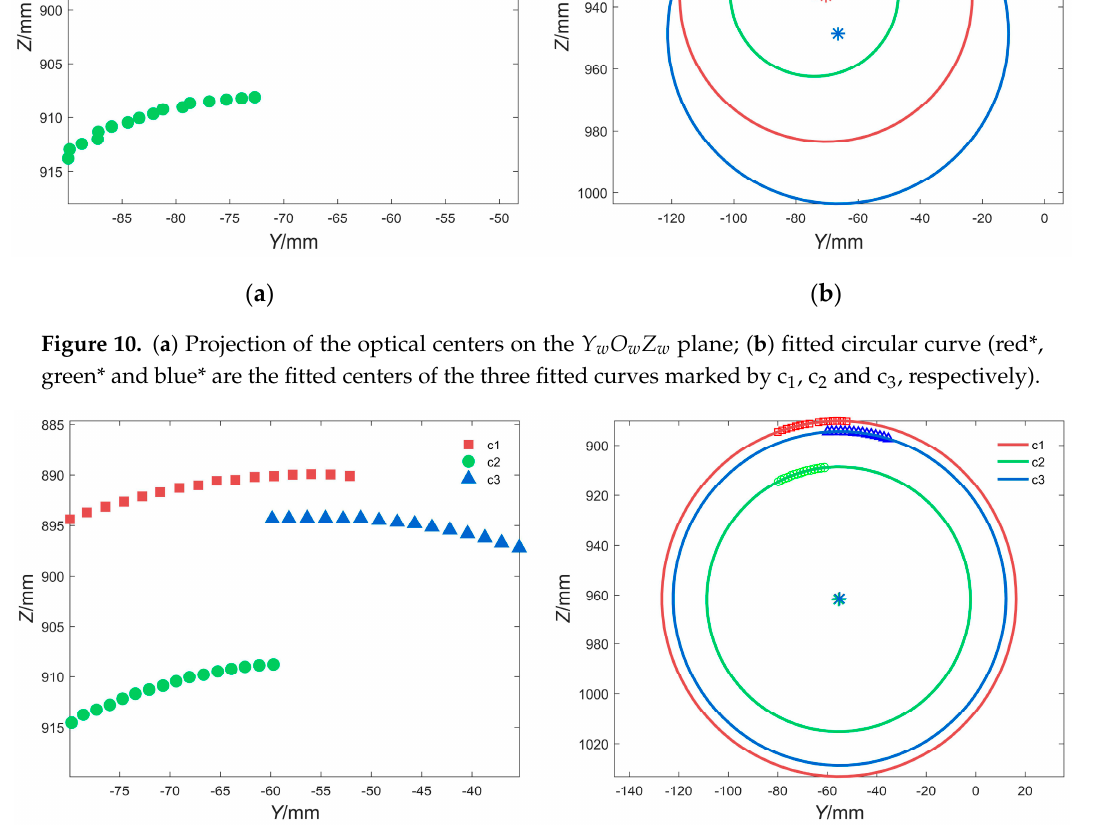
Figure 9. ( a ) Graph of the rotation angles γ ix ( j ), γ iy ( j ) and γ iz ( j ); ( b ) graph of the rectified rotation